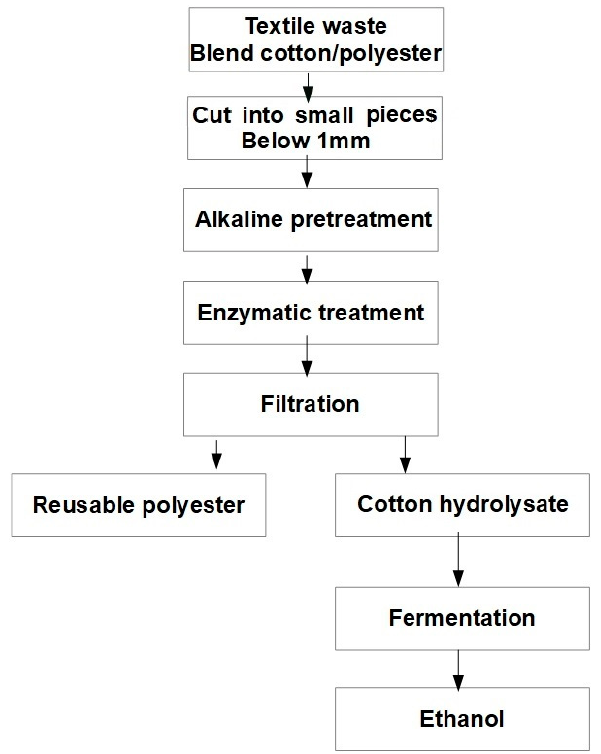
Figure 8. Schematic diagram of cotton-polyester waste blend valorization.